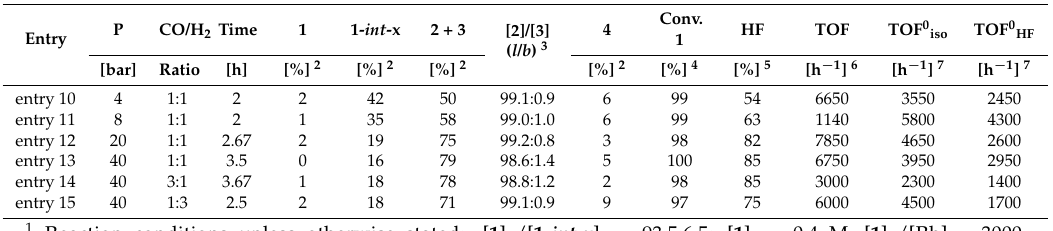
Table 3. Influence of syngas pressure on tandem isomerization-hydroformylation of 10-undecenitrile at [ 1 ] 0 /[Rh] = 3000 1 .